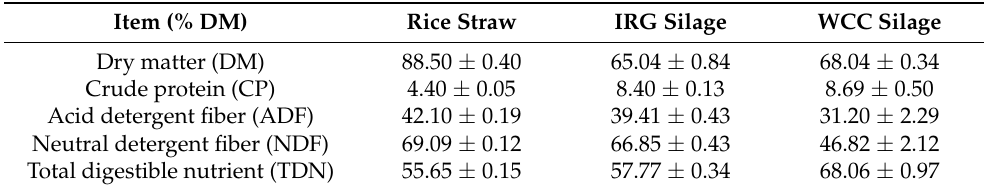
Table 1. Nutrient compositions of rice straw, Italian ryegrass (IRG) silage, and WCC silage.